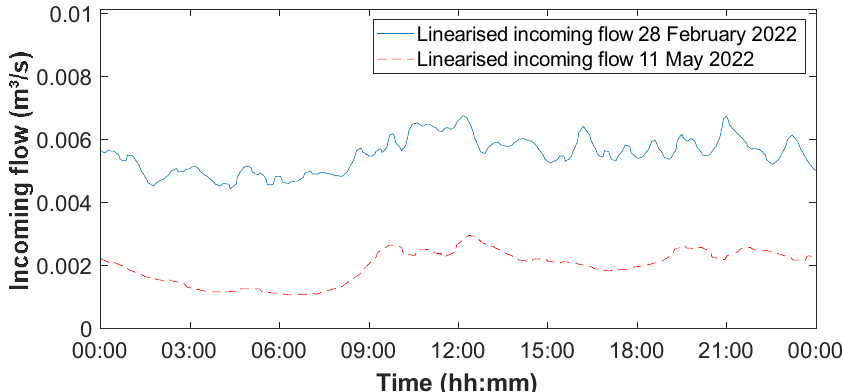
Figure 11. Calculated incoming flows at the start and end of a dry period with high initial infiltration (PS Zuidstraat).